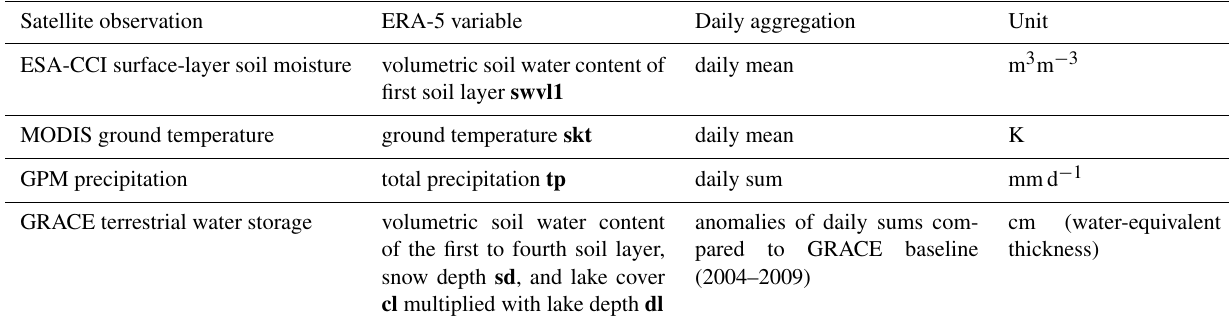
Table A1. Mapping of ERA-5 variables (in bold) with satellite observations.